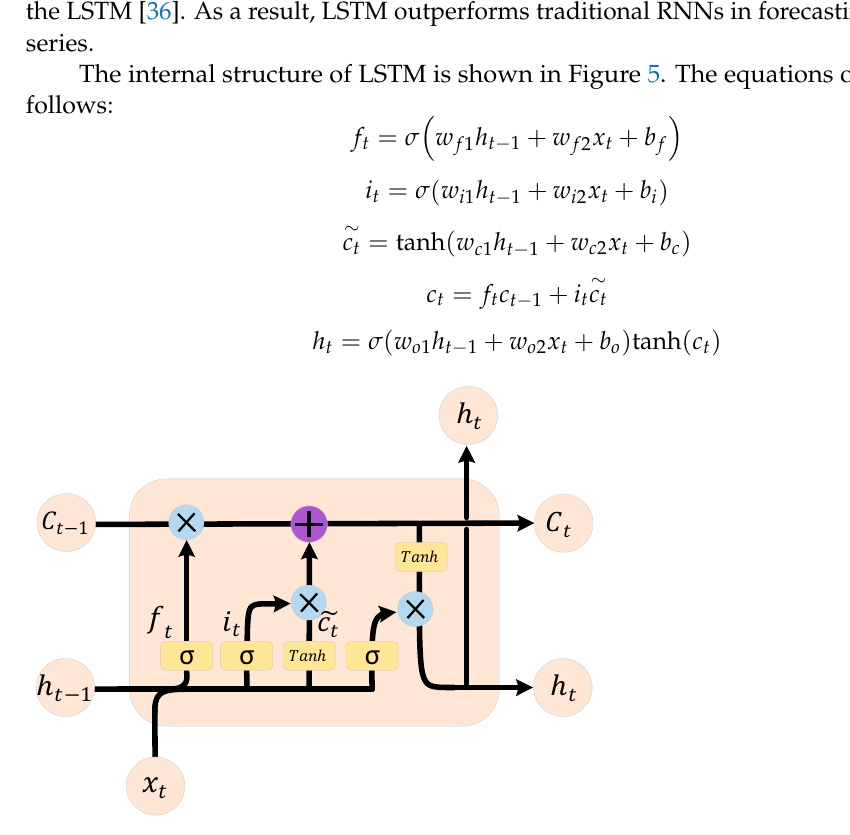
Figure 5. LSTM neuron structure.